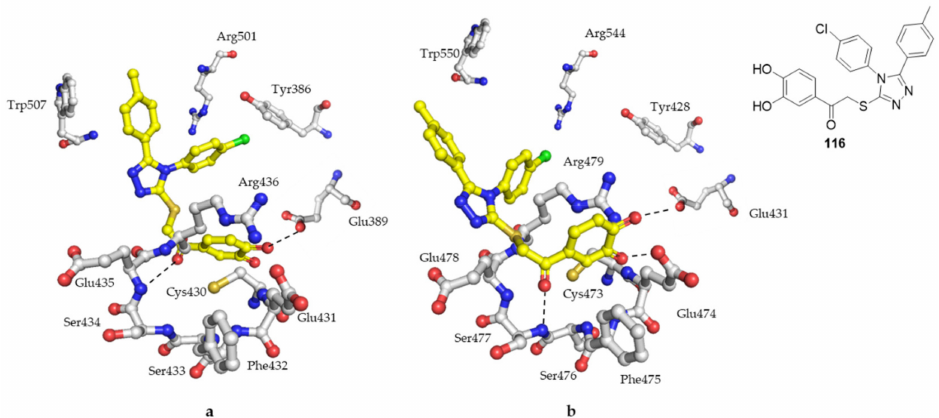
Figure 11. The theoretical binding orientations of 116 (yellow stick) in the active sites of ( a ) Cdc25A and ( b ) Cdc25B.